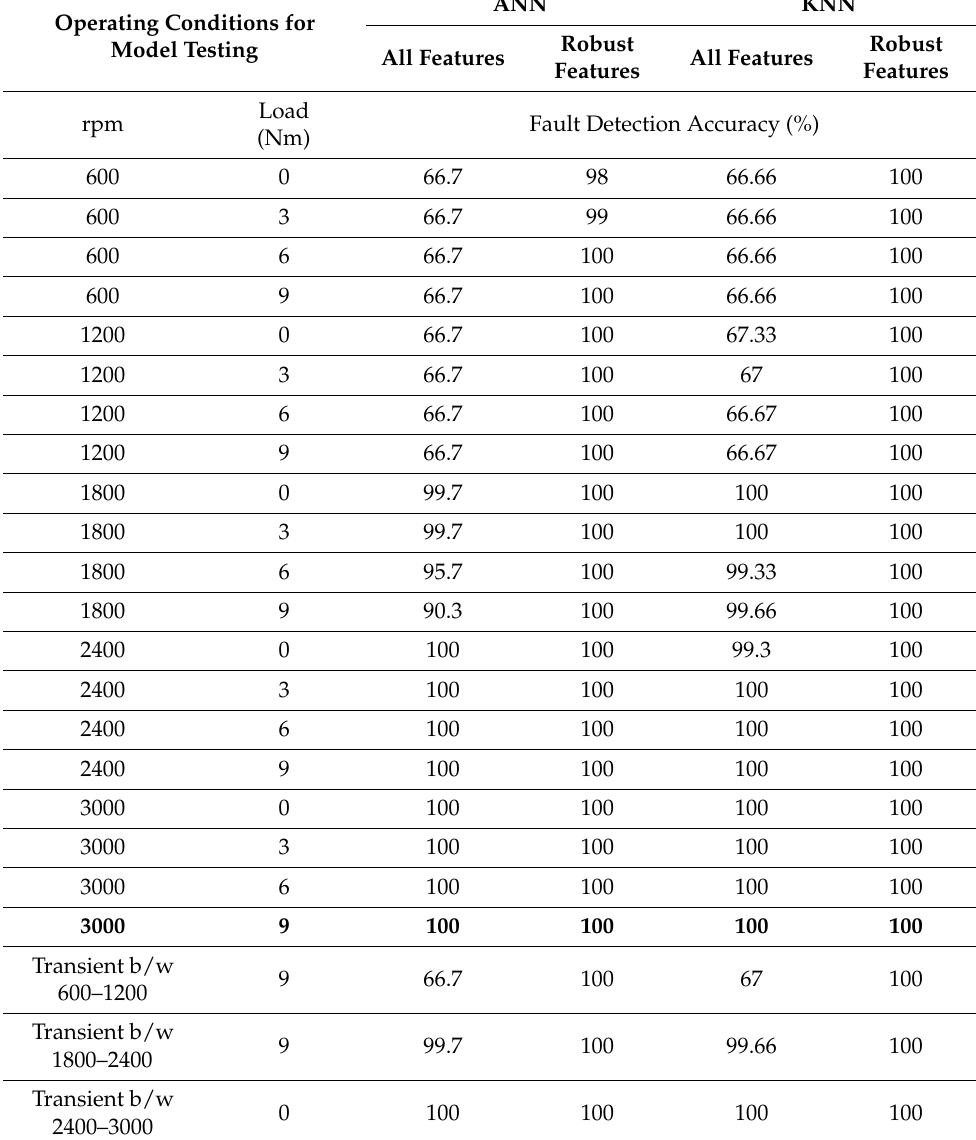
Table 4. Performance of AI models trained at maximum speed and load (3000 rpm and 9 Nm